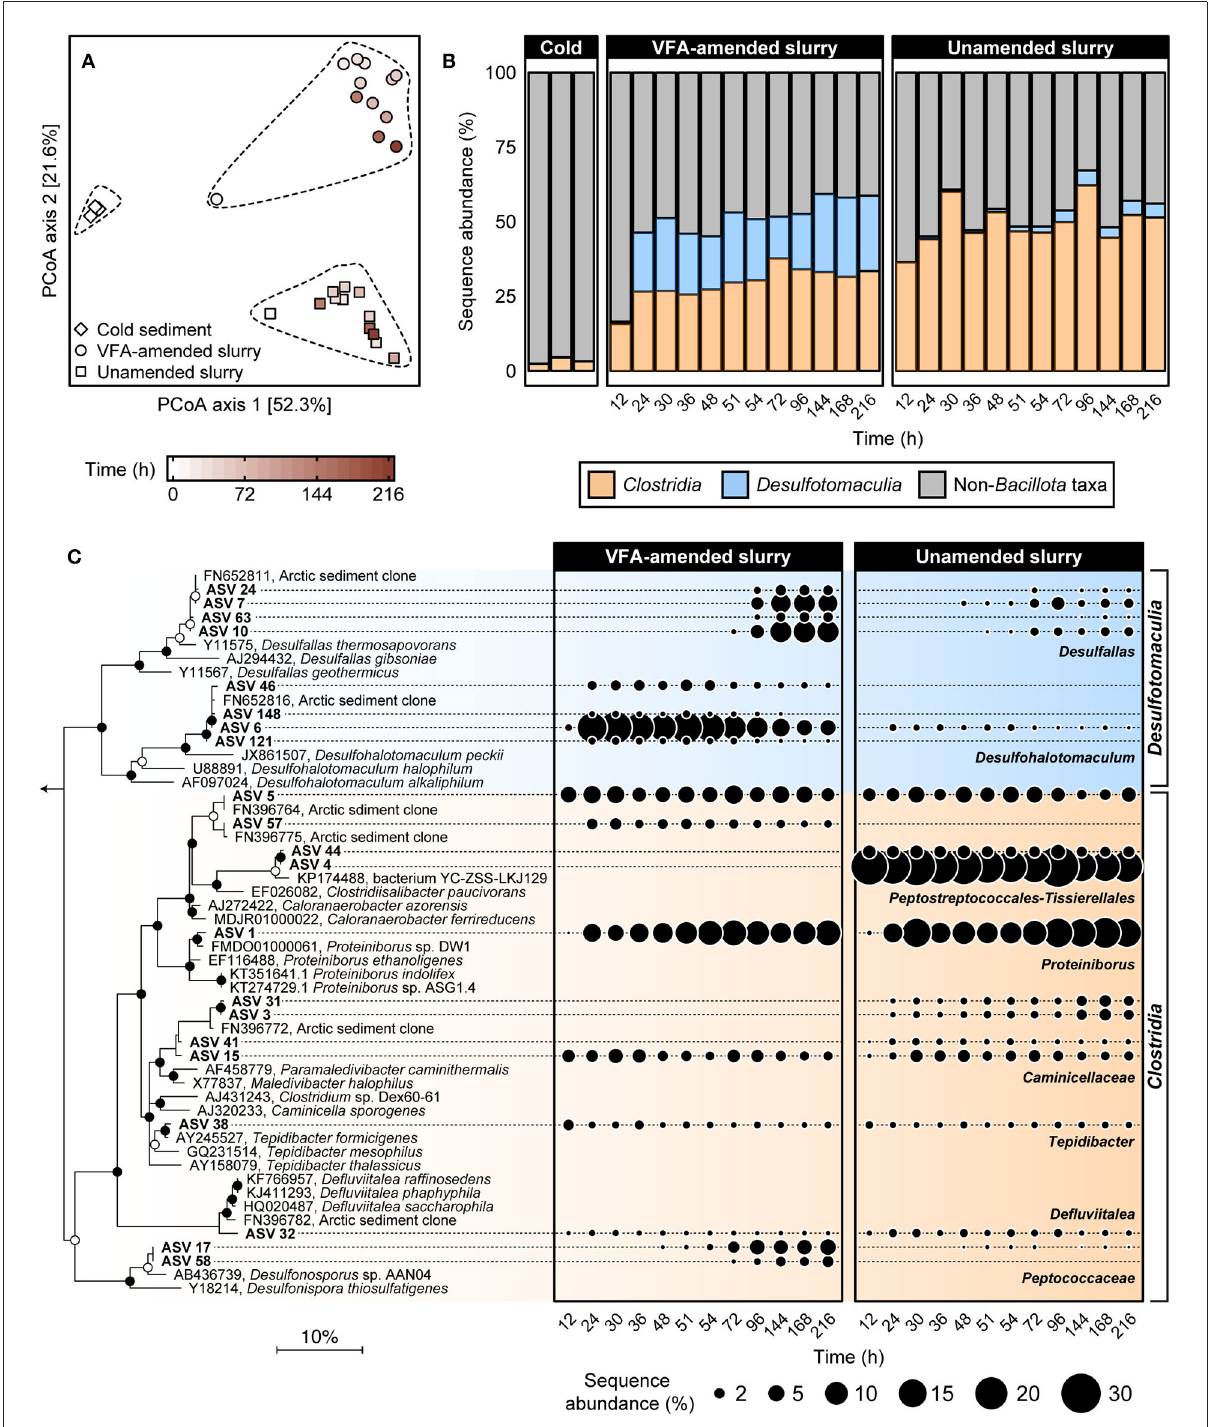
FIGURE2 Comparison of bacterial community similarity in cold sediments before and after heating with or without VFA amendment based on weighted UniFrac distances (A) . The 27 different 16S rRNA gene amplicon libraries were randomly subsampled to 16,667 reads to account for unequal sequencing depth across libraries and to ensure comparability of sample diversity. Heating to 50 ◦ C led to an enrichment in relative sequence abundance of bacterial classes Clostridia and Desulfotomaculia within the phylum Bacillota over a 12–216h time period (B) . Relationships among 21 spore-forming bacterial ASVs enriched in slurry incubations together with close relatives ( > 96% sequence identity) are shown in the maximum likelihood phylogenetic tree (C) . Filled and open circles at branch nodes indicate lineages with > 80% and 50–80% bootstrap